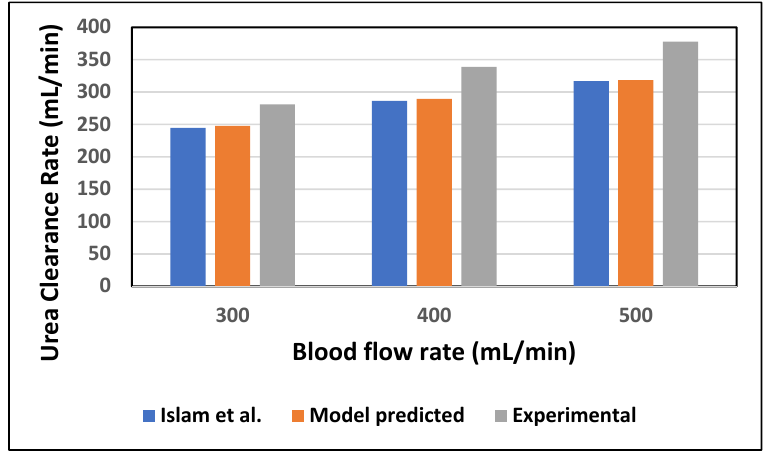
Figure 4. The urea clearance rate for in-silico and in-vitro cases at varying blood flow rate with constant dialysate flow rate (Q D = 500 mL/min).